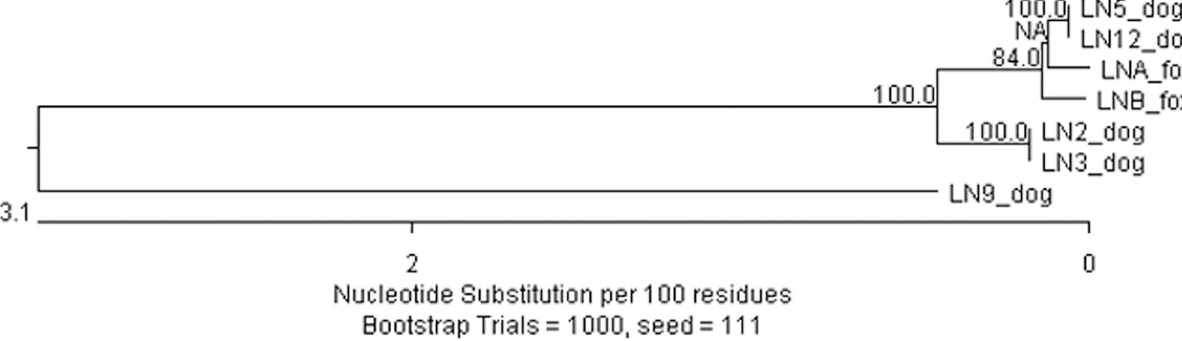
Fig 1. Phylogenetic tree generated by ClustalW (MegAlign, DNASTAR Version 15.0.0).